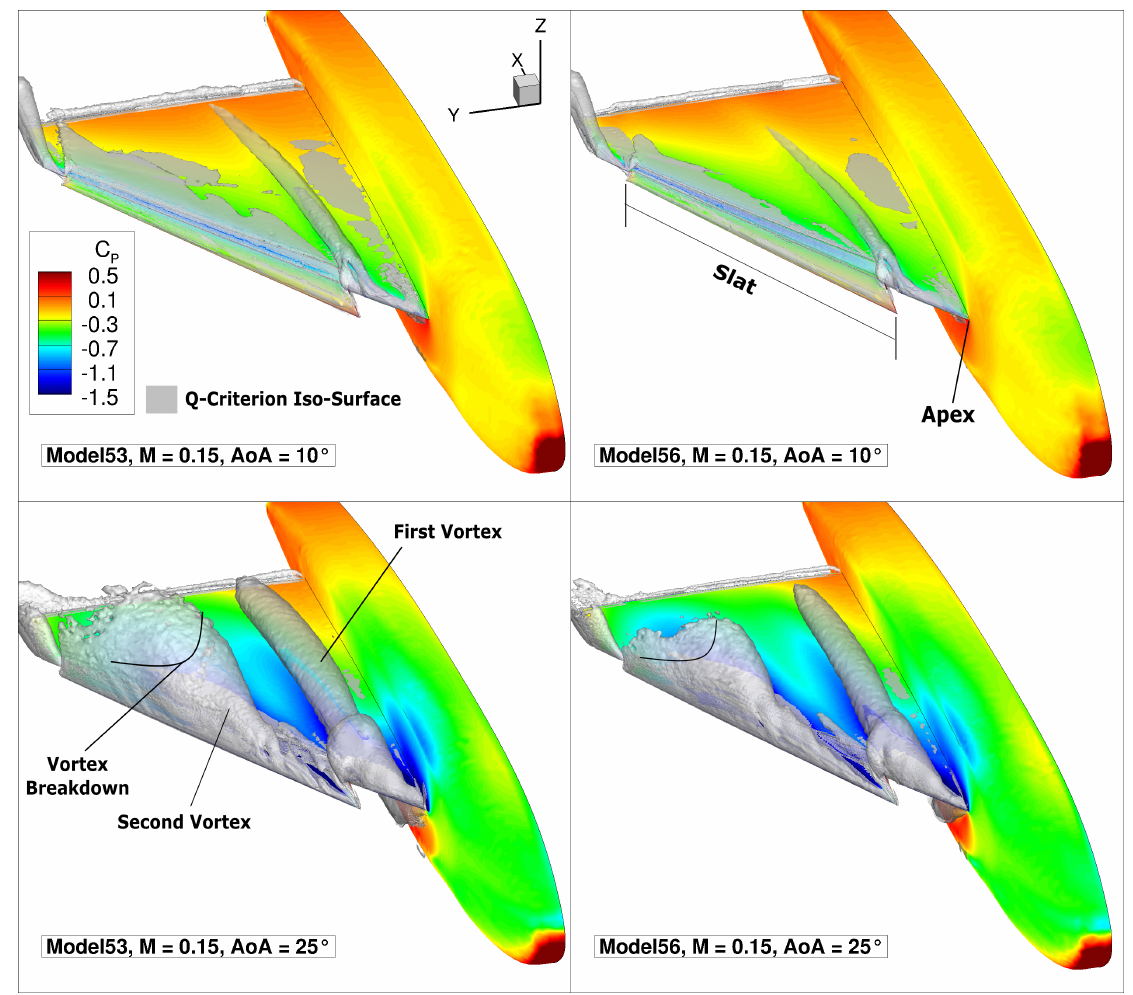
Figure 14. Visualization of the vortical flow field by means of a Q-Criterion isosurface on Models 53 and 56 numerical simulations with the SAE turbulence model at α = [10, 25] ◦ ; showing also, the surface C p